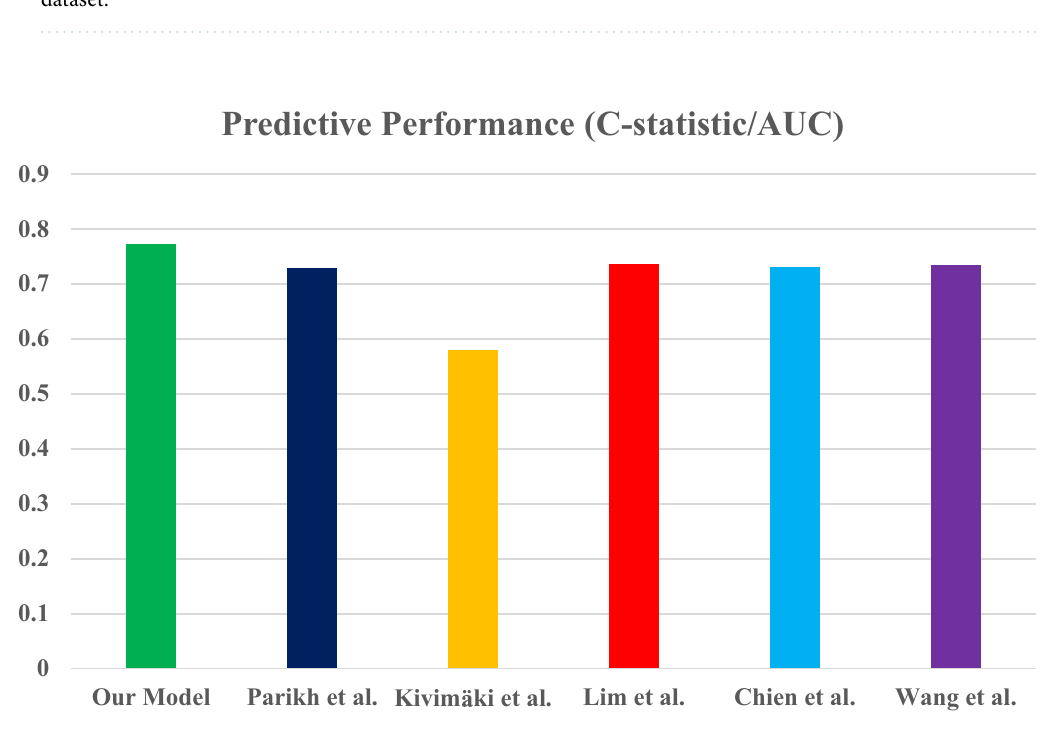
Figure 6. Comparison of the newly developed model’s prediction performance with that of some previously published